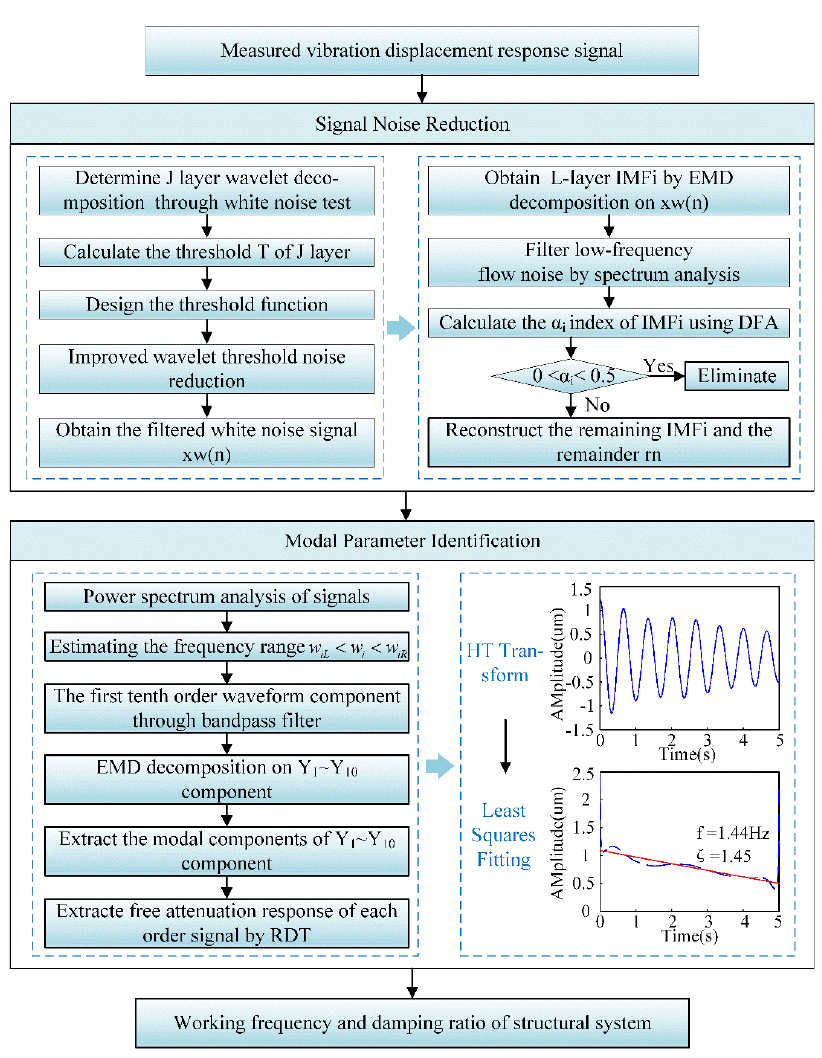
Figure 2. Flow chart of modal parameter identification of high arch dam discharge